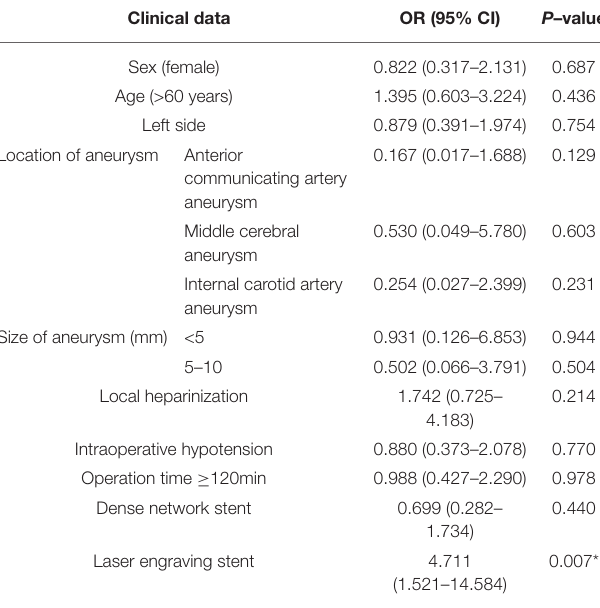
TABLE 4 | Univariate analysis results of DWI abnormalities after endovascular treatment for intracranial aneurysms. Clinical factors